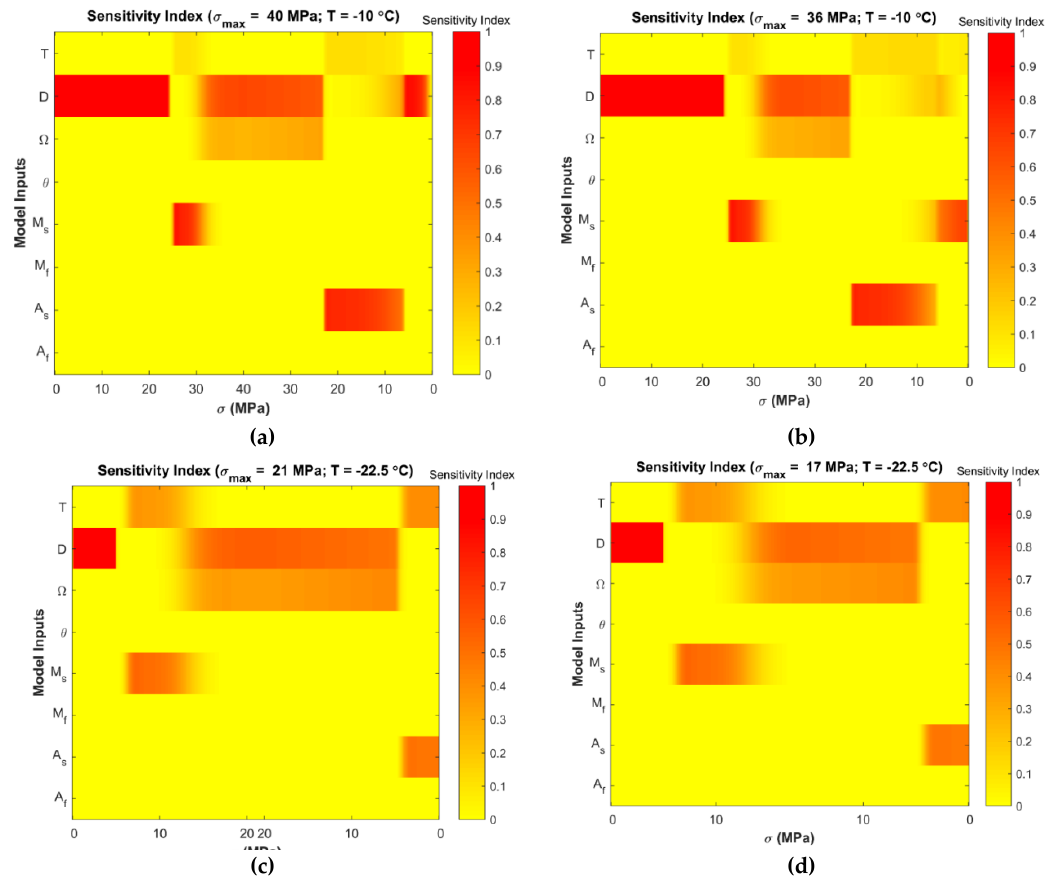
Figure 5. Extended Fourier Amplitude Sensitivity Test (eFAST) stress-dependent sensitivity index distribution at simulated temperatures for the Tanaka model (the corresponding stress values during loading and unloading are shown in horizontal axis and inputs are shown in vertical axis): ( a ) T = − 10 ◦ C, σ max = 40 MPa; ( b ) T = − 10 ◦ C, σ max = 36 MPa; ( c ) T = − 22.5 ◦ C, σ max = 21 MPa; ( d ) T = − 22.5 ◦ C, σ max = 17 MPa.